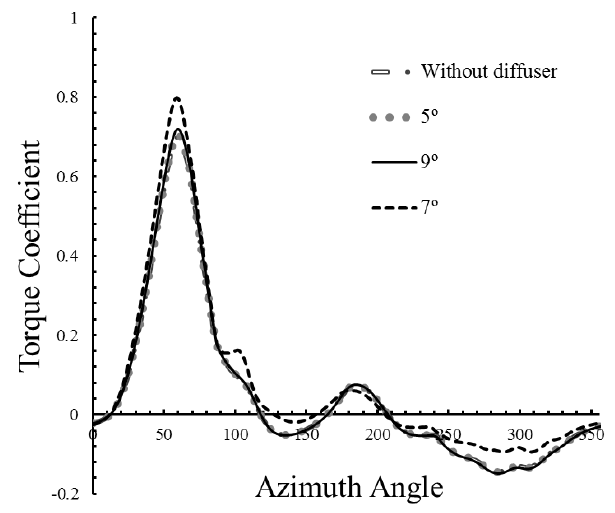
Figure 11. Effect of angle of diffusers on torque coefficient.